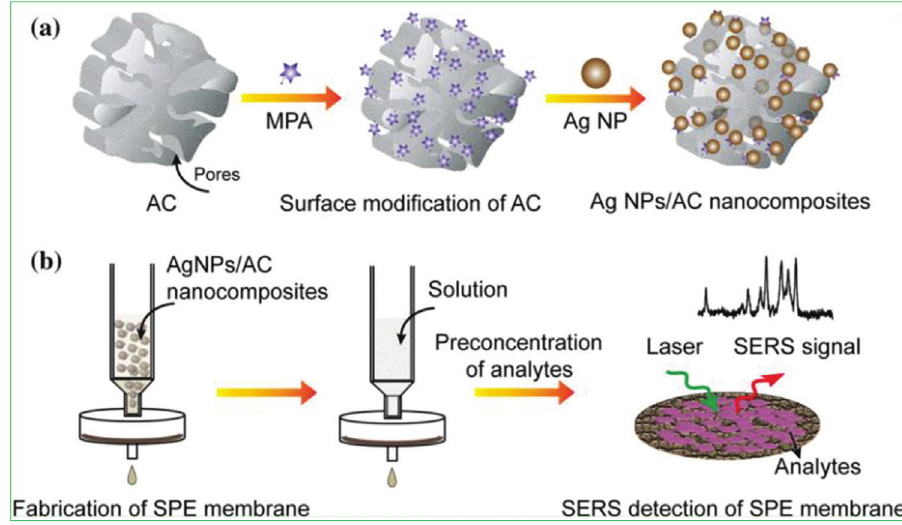
Figure 3: Scheme of the fabrication of the Ag NPs/AC nanocomposites and its application to preconcentration and SERS detection of analytes in water. Reproduced with permission from Ref. [30]. Copyright: 2018